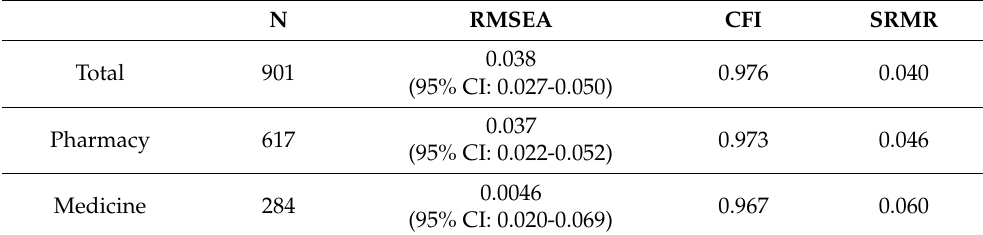
Table 3. Diagnostic adjustment criteria for SPICE-R2F.